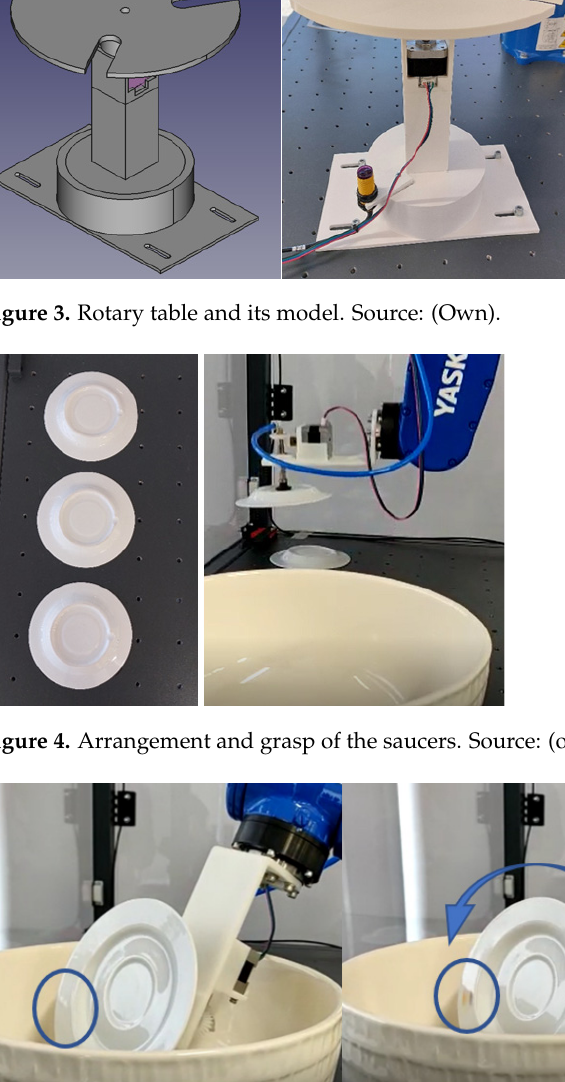
Figure 3. Rotary table and its model. Source: (Own).